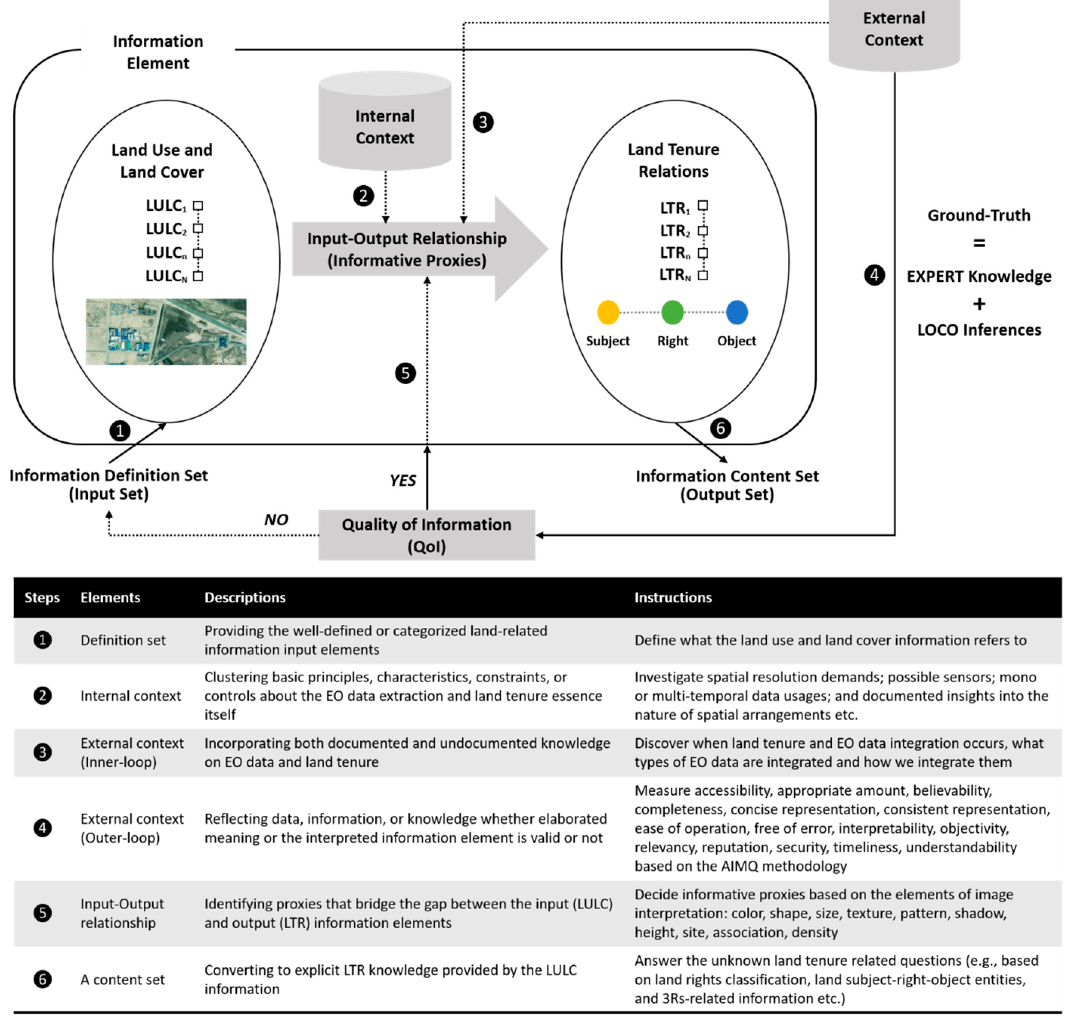
Figure 2. The general structure of an information element and its processes for the interpretation of the semantic land tenure relations (devised by the authors).